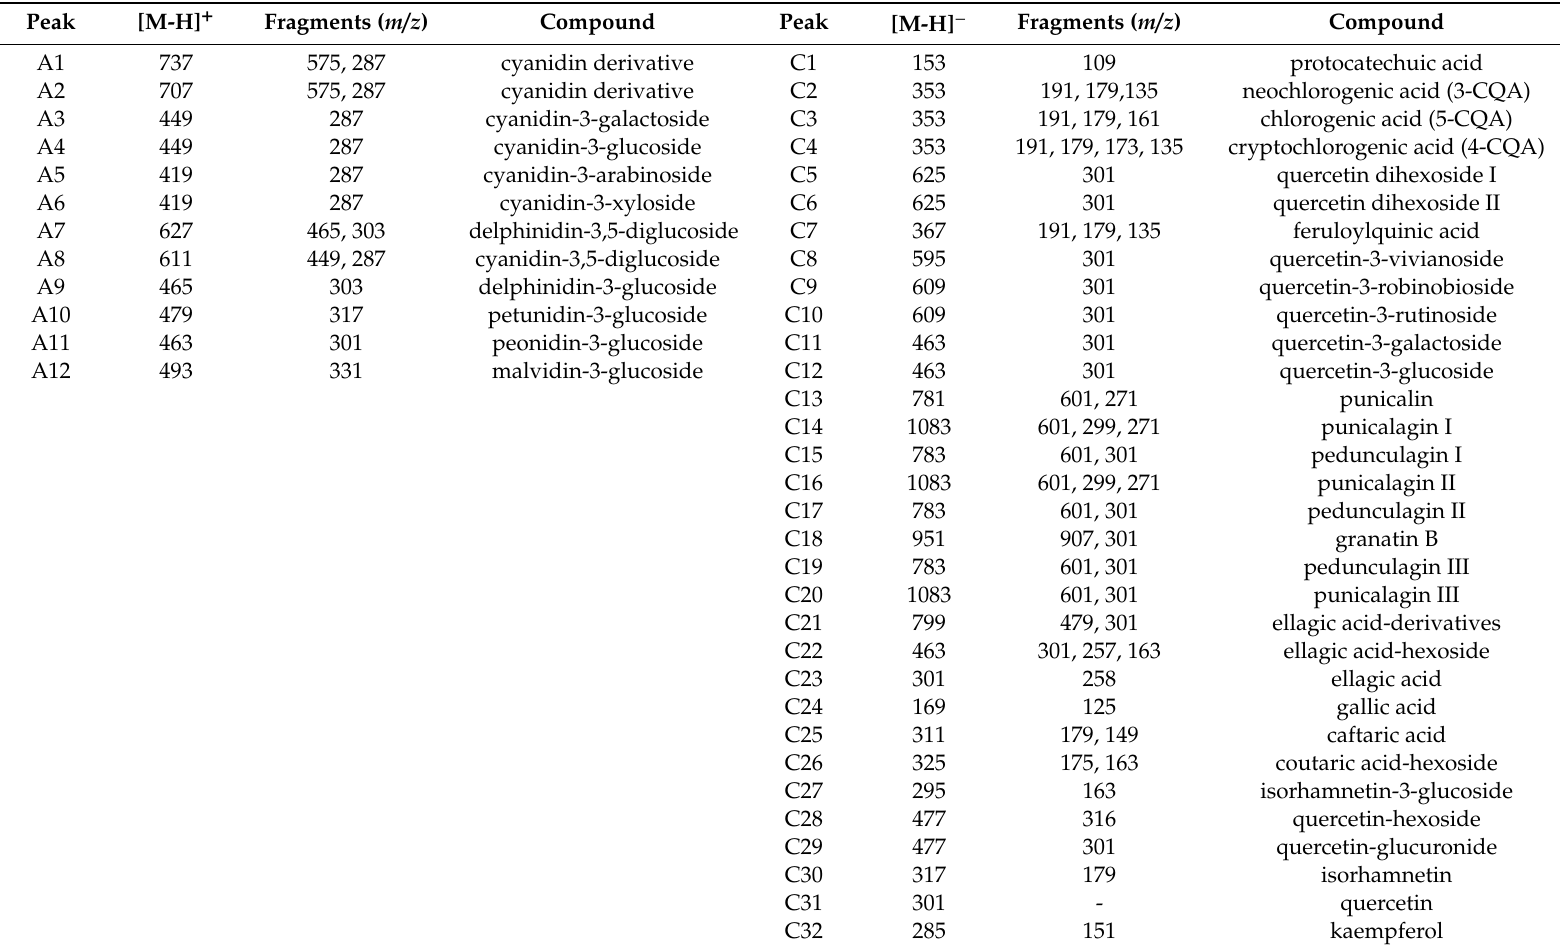
Table 1. HPLC-ESI-MS / MS data of separated anthocyanin and copigment fractions after membrane chromatography of aronia NFC, pomegranate NFC, and red grape